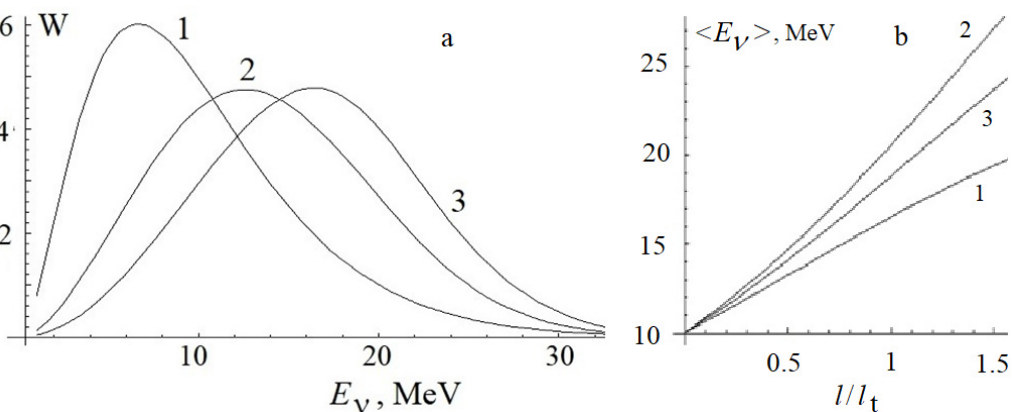
Figure 3. ( a ) Neutrino energy spectra in arbitrary units for α = 2, E av = 10 MeV, and e l = 1 (i.e., l = 0)—curve 1, 2—curve 2, and 3—curve 3 average over T from 5 MeV to 10 MeV. ( b ) The average neutrino energy depending on the path length l. For α = 2, E av = 10 MeV, T = 5 MeV—curve 1 and 10 MeV—curve 2. Curve 3 corresponds to the average over temperature T in the range of 5 to 10 MeV.